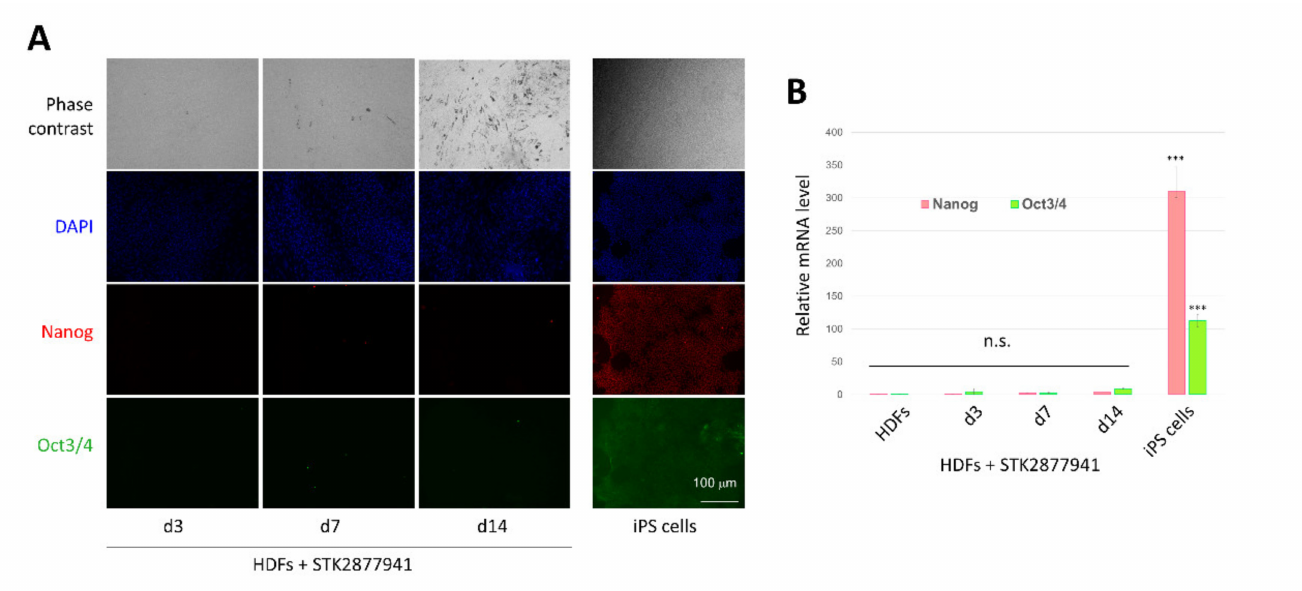
Figure 4. A pluripotent state does not occur during conversion from HDFs to CCCAs. HDFs were cultured with STK287794 as in Figure 3 for the indicated number of days. ( A ) Cells were stained with anti-Nanog and anti-Oct3/4 antibodies, and nuclear staining was performed with DAPI. As a positive control, human iPS cells were also stained. Fluorescence microscopic images are shown (original magnification: × 100). ( B ) RNA was extracted from the cells and subjected to real-time RT-PCR to evaluate Nanog and Oct3/4 mRNA levels. Values (mean ± SD) are normalized with respect to the β -actin mRNA level in each sample. Relative values to the control were calculated ( n = 3 for each group). *** p < 0.001 vs. control group. n.s: not